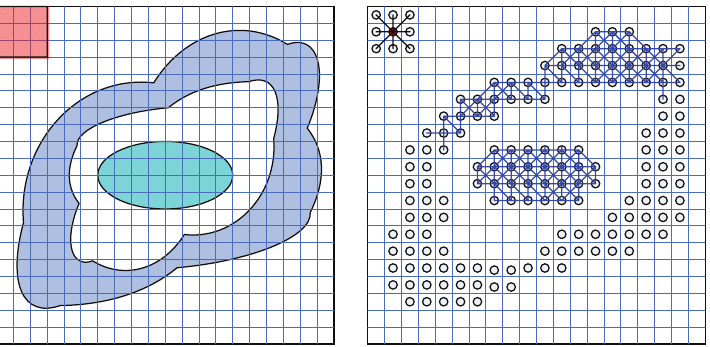
Figure 4: An example of flexible grid with induced